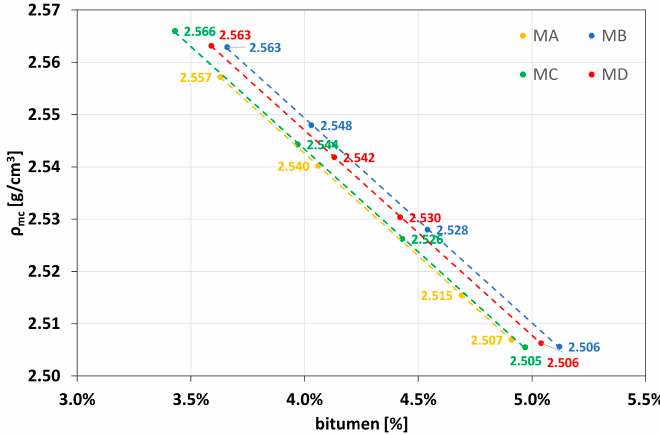
Figure 2. Theoretical maximum density.